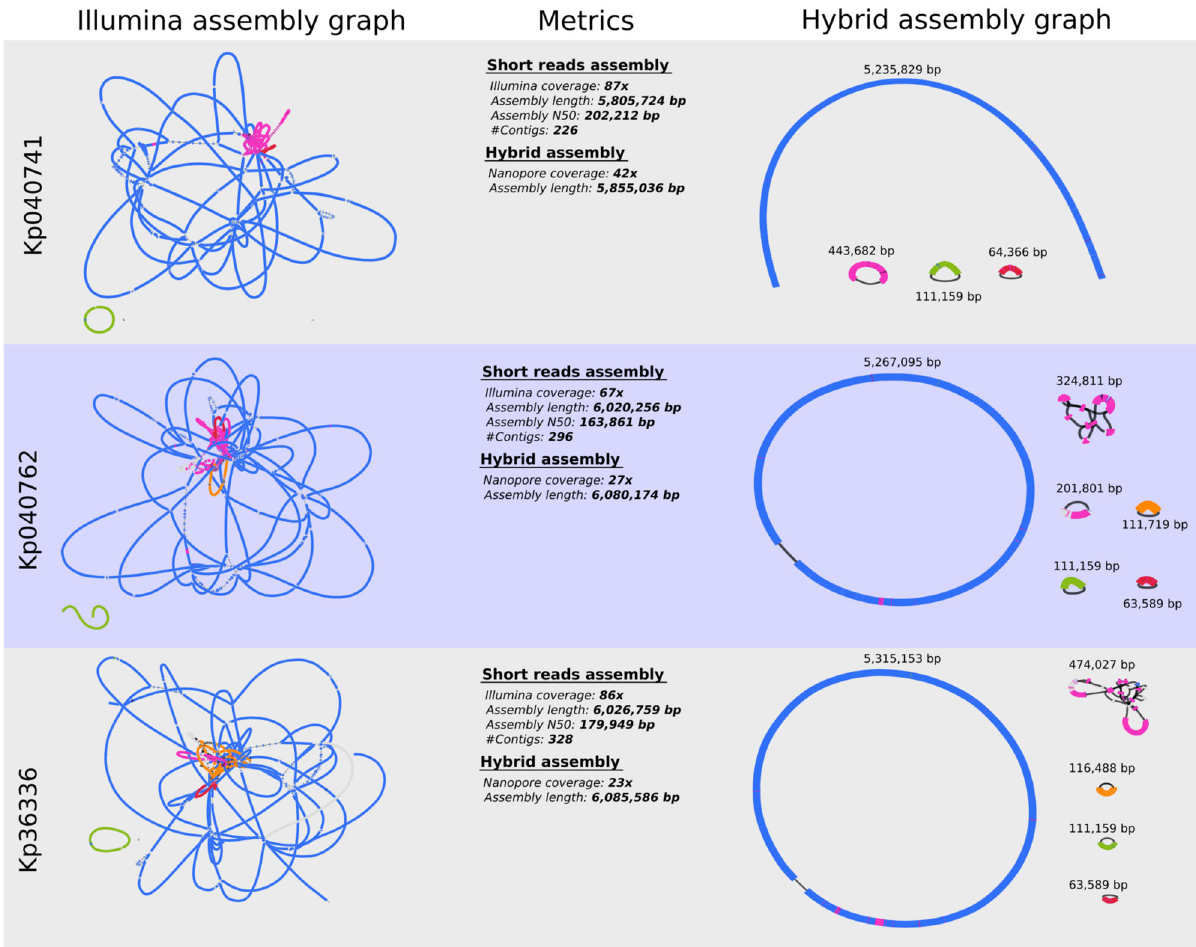
Fig. 4 Bandage visualization of the short-reads (Illumina) and hybrid (Illumina + Nanopore) assembly graphs of Klebsiella pneumoniae isolates Kp040741, Kp040762, and Kp36336. The different replicons can be distinguished in the hybrid assembly graphs and include the chromosome and up to fi ve plasmids (isolate